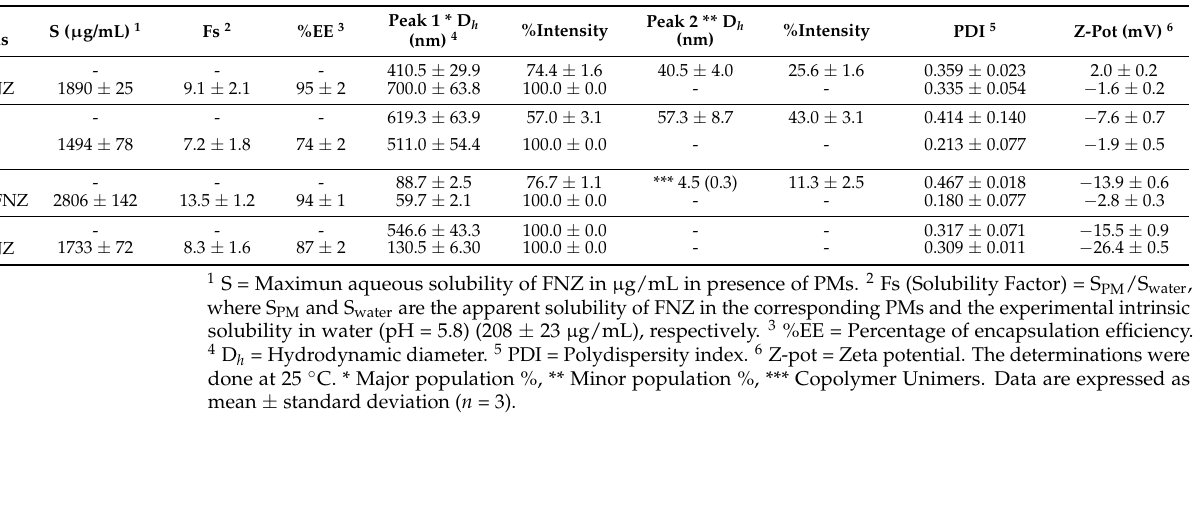
Table 1. Characterization of PMs with and without FNZ cargo in aqueous